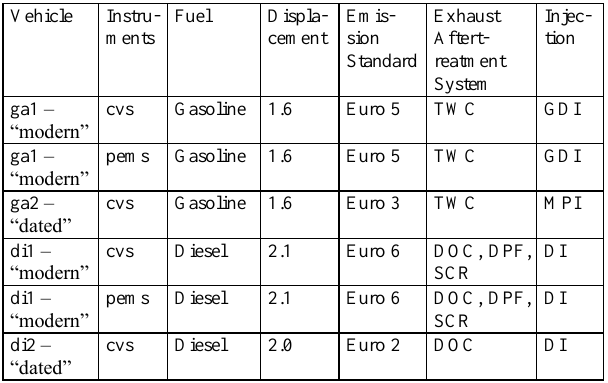
Table 2. List of vehicles used for reproduction of non-driving situations on chassis dynamometer (ga – gasoline, di –